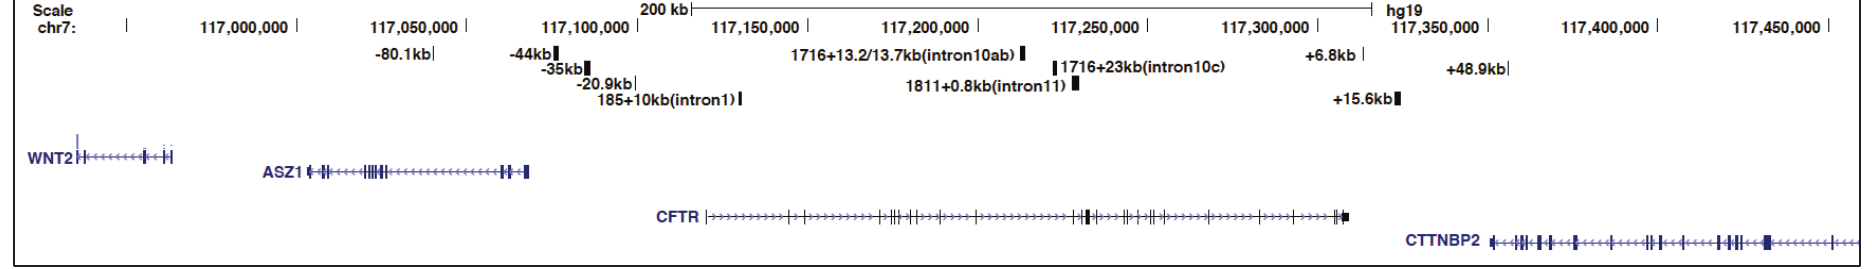
Figure 1. Schematic to show to the genomic location of the cystic fibrosis transmembrane conductance regulator ( CFTR ) locus and some of its key cis -regulatory elements discussed in this review. From the University of California, Santa Cruz (UCSC) genome